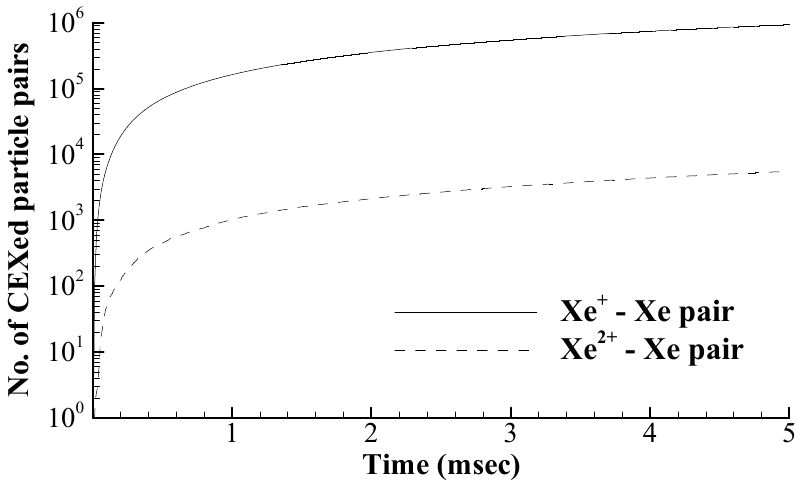
Figure 13. Accumulated number of particle pairs that underwent charge exchange in Case 1. To verify the results, the axial variations in the magnitude of the velocity of the Xe atoms and ions along the thruster channel center are shown in Figure 14. With CEX effects, the average velocity of the particles was 888 m/s for the Xe atoms, 16.9 km/s for the Xe + ions, and 23.8 km/s for the Xe 2+ ions. In other words, due to the strong electric forces on the doubly charged Xe 2+ ions, the Xe 2+ ions are much faster than the other particles. Therefore, sputtering and erosion by impingement of Xe 2+ ions on the satellite body can be much more severe than that by other particles. As shown in Figure 14a, the Xe atoms were faster with CEX effects than without CEX effects. However, in Figure 14b, the Xe + ions were slower with CEX effects than without CEX effects. This was because CEX between Xe + and Xe generated a number of low-speed Xe + ions and high-speed Xe atoms. However, as shown in Figure 14c, the speed of Xe 2+ upstream (axial distance < 0.1 m) was not remarkably different for the cases with and without CEX effects. This meant that CEX between Xe 2+ and Xe rarely occurred, and low-speed Xe 2+ ions were rarely generated. Therefore, even with CEX effects, scattered Xe 2+ ions were not noticeable in Figure 11.